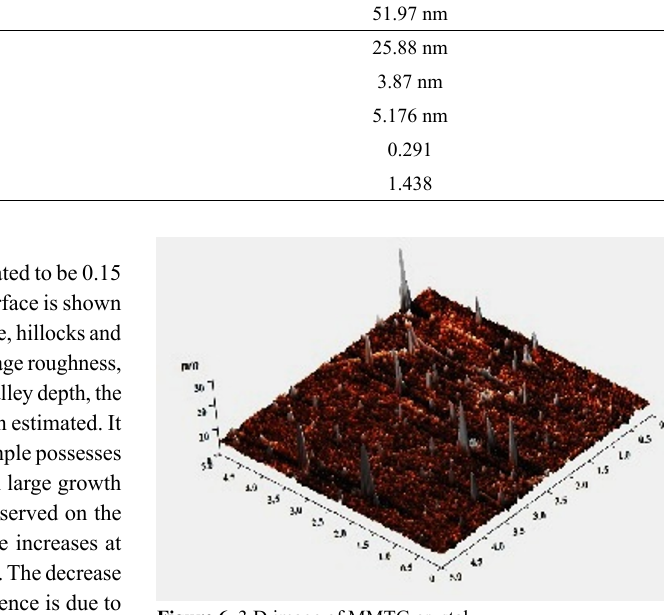
Figure 6. 3 D image of MMTG